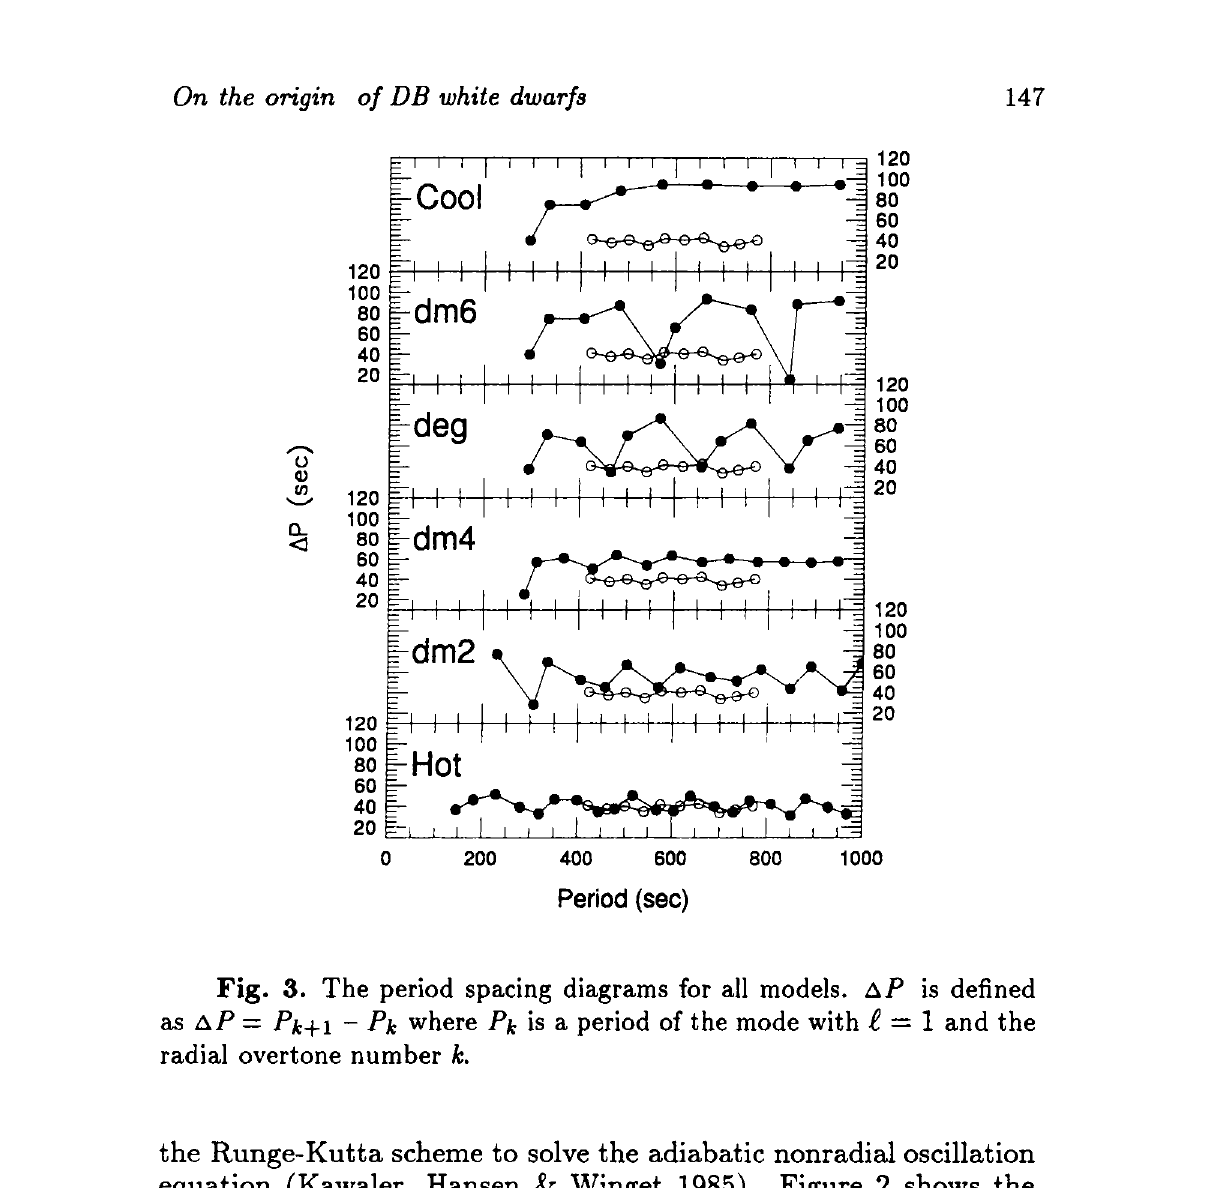
Fig. 3. The period spacing diagrams for all models. AP is defined as A P = Pk+i ~ Pk where P\ t is a period of the mode with £ = 1 and the radial overtone number